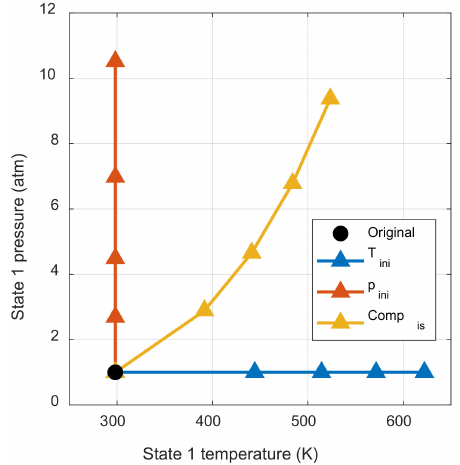
Figure 8. Initial thermodynamic state change by each process.